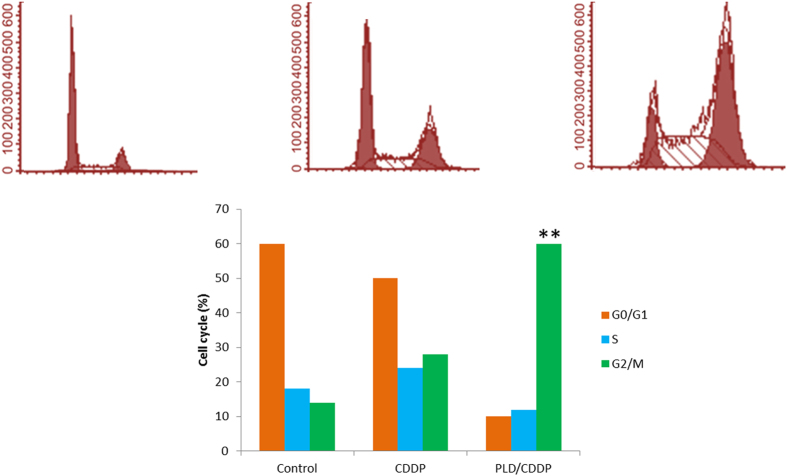
Cell cycle analysis of MG63 cancer cells after treatment with free CDDP and PLD/CDDP for 24 h.The respective cell percentages in G2/M and G0/G1 phases are presented in the bar graph. Data are expressed as standard deviation of the mean and n = 4. **p < 0.01 is the statistical difference between G2/M phase expression of CDDP and CDDP/PLD treated group.